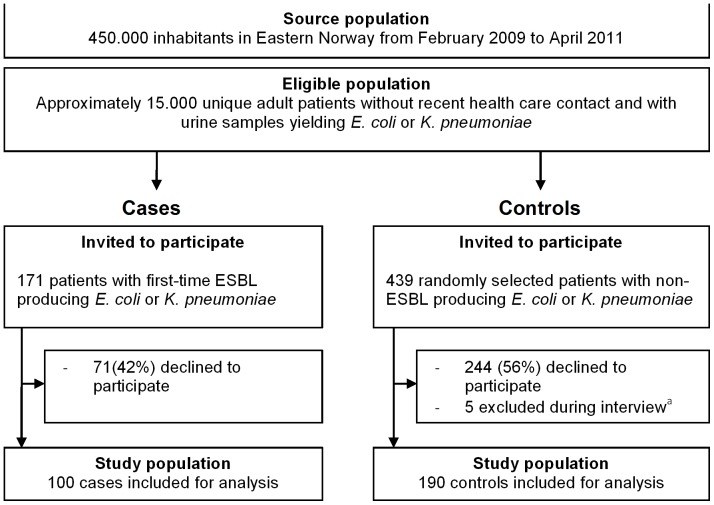
Selection of study population.
aDementia (n = 1), unable to reach by phone (n = 2) and death (n = 2).